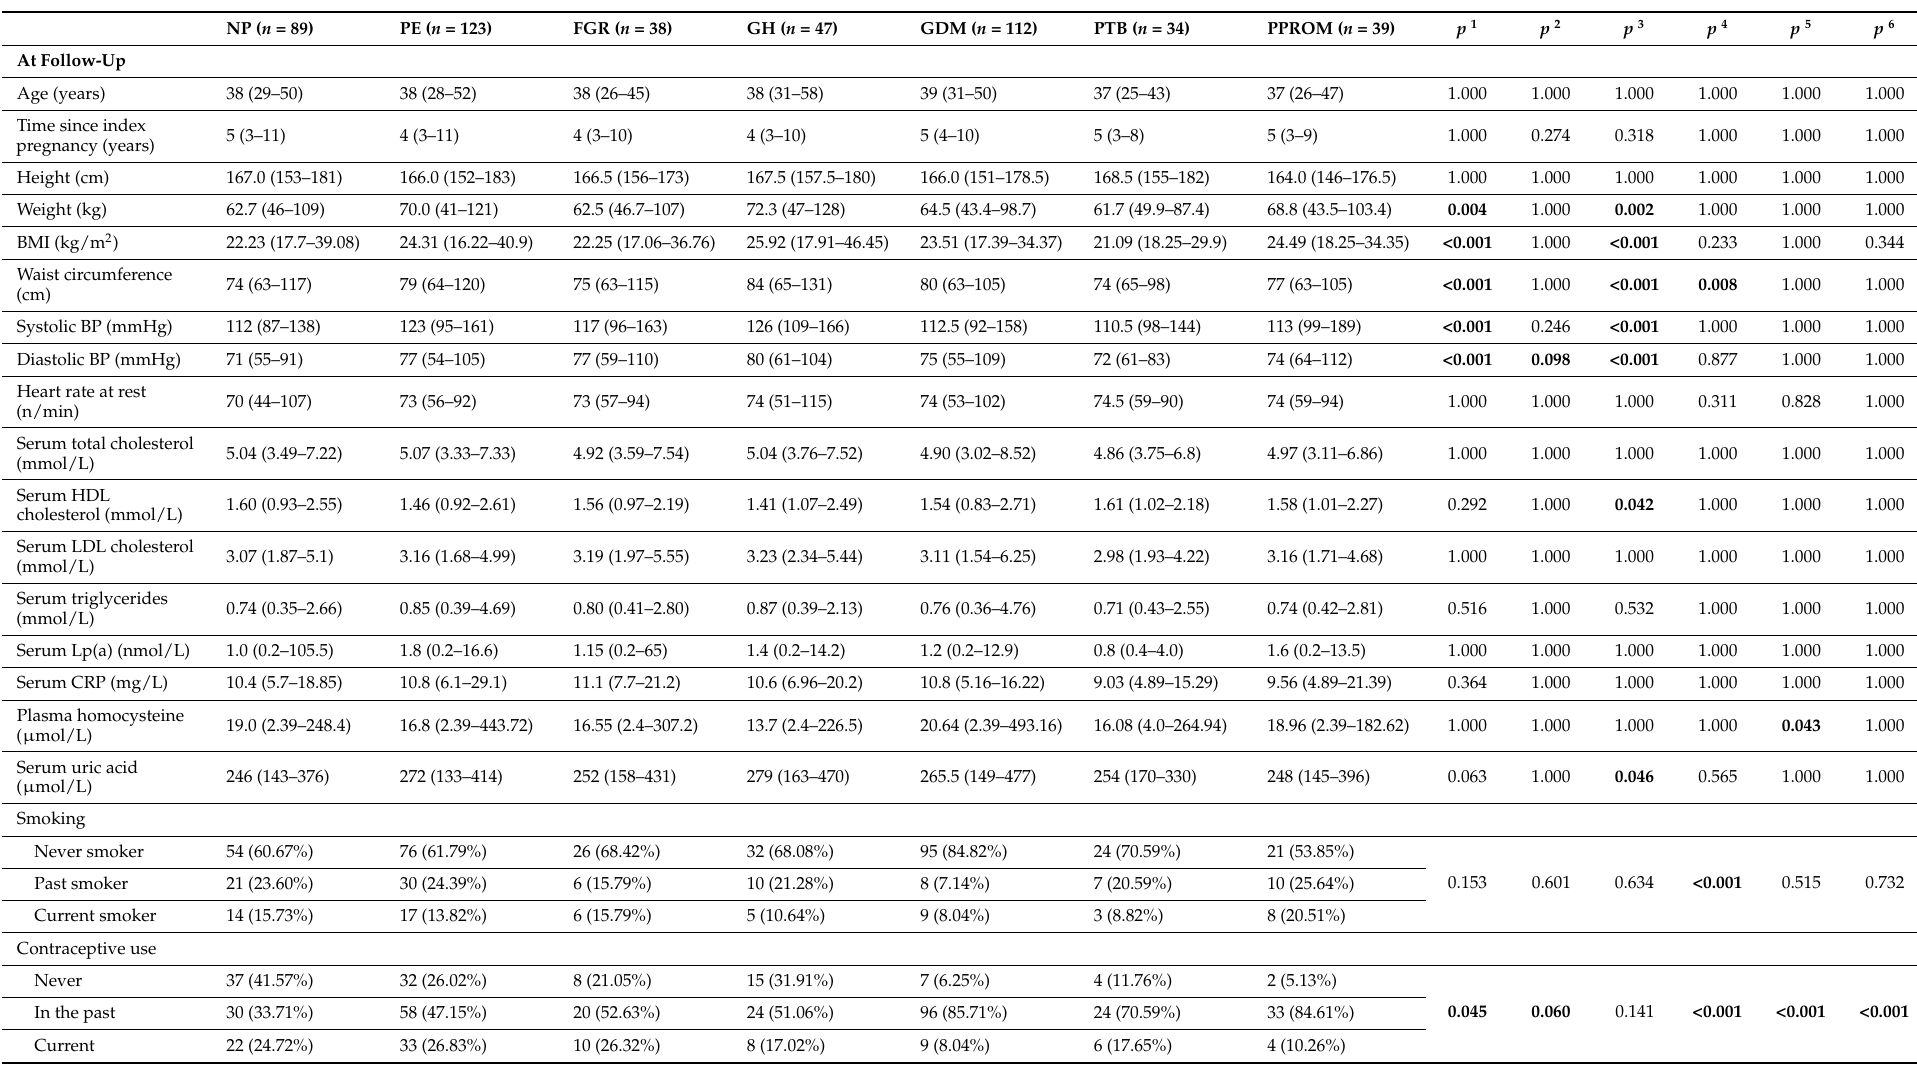
Table 1. Characteristics of cases and